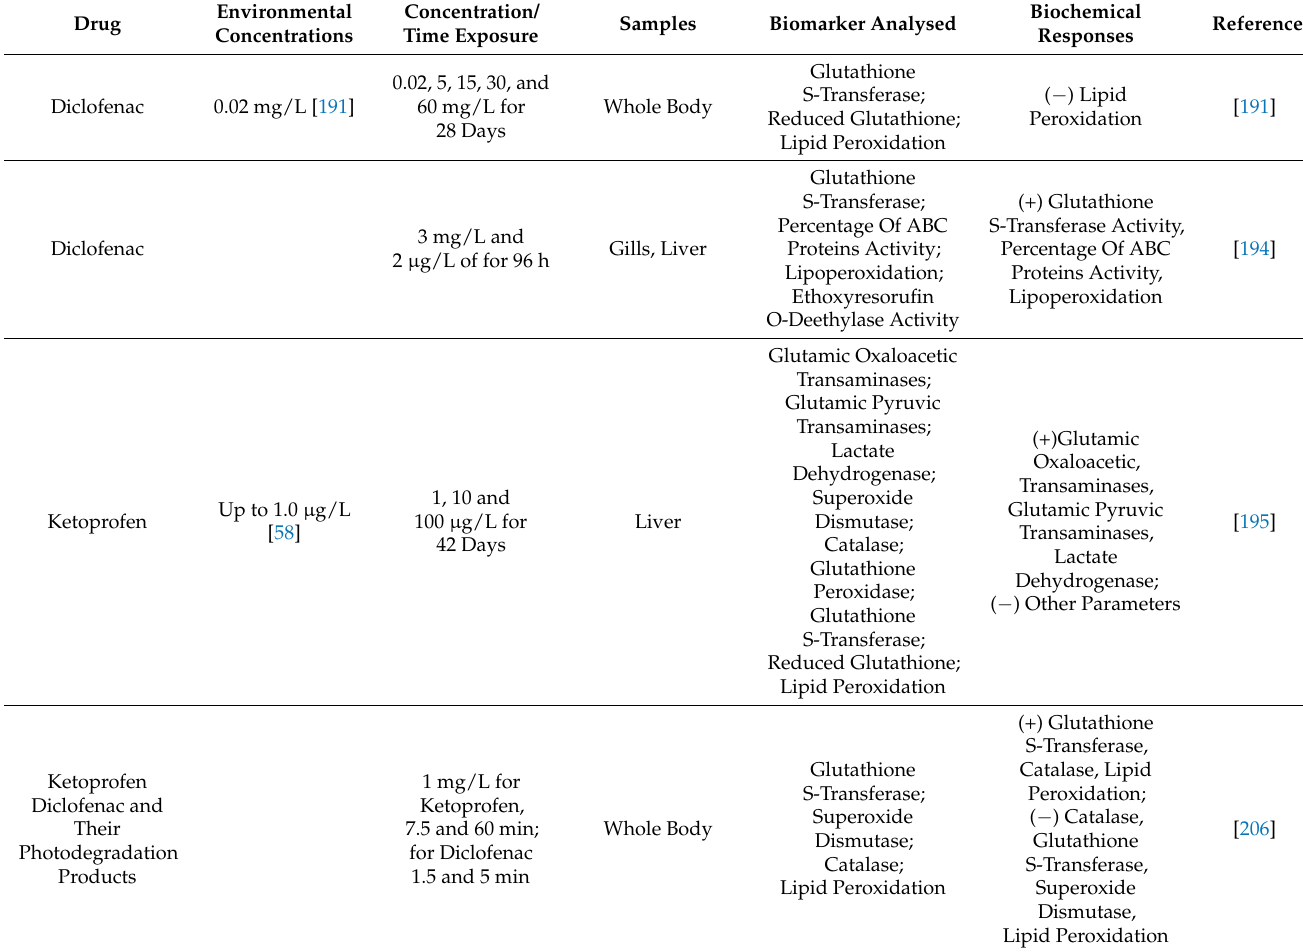
Samples Biomarker Analysed